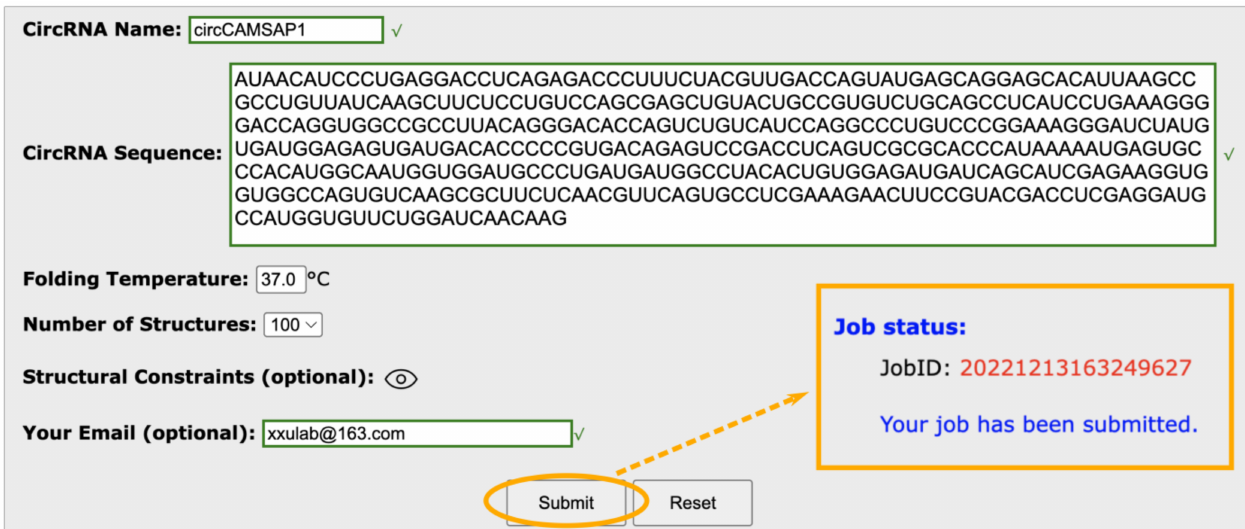
Figure 1. Snapshot of the input of the cRNAsp12 server. Once a calculation is submitted, a notification page containing the assigned job ID, as indicated by the dashed arrow, is displayed.